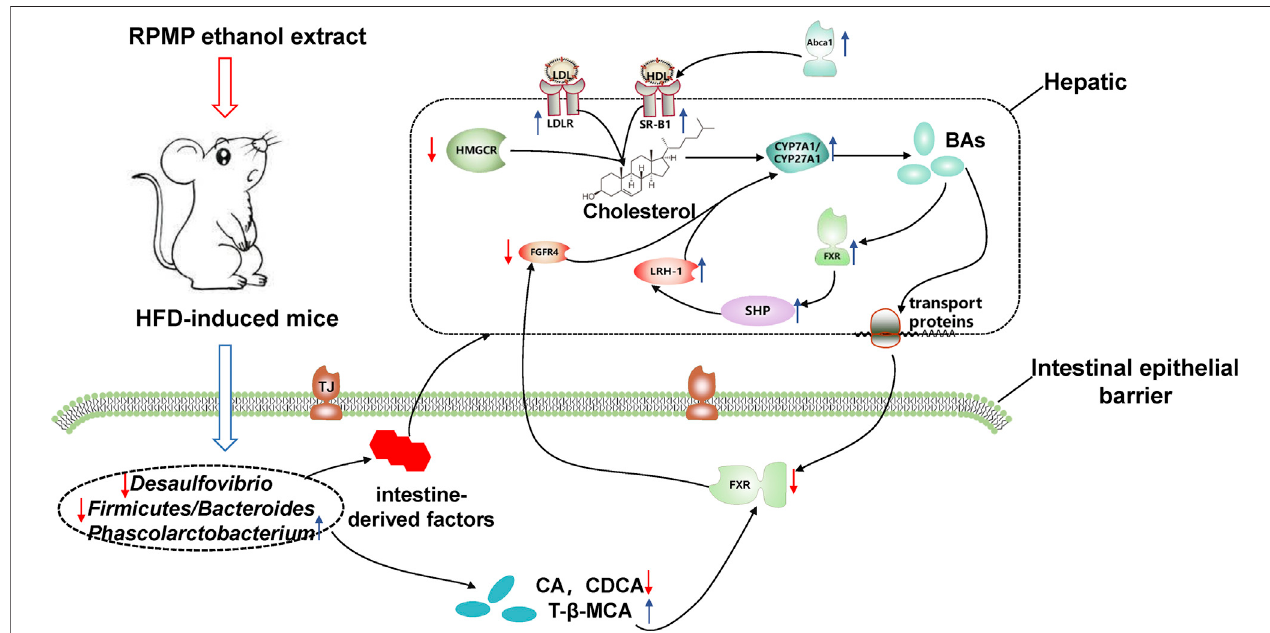
FIGURE 13 | Potential mechanism of action of RPMP alcoholic extracts. The blue arrow showed that the RPMP ethanol extract increased the expression, the red arrow showed that the RPMP ethanol extract decreased the expression.